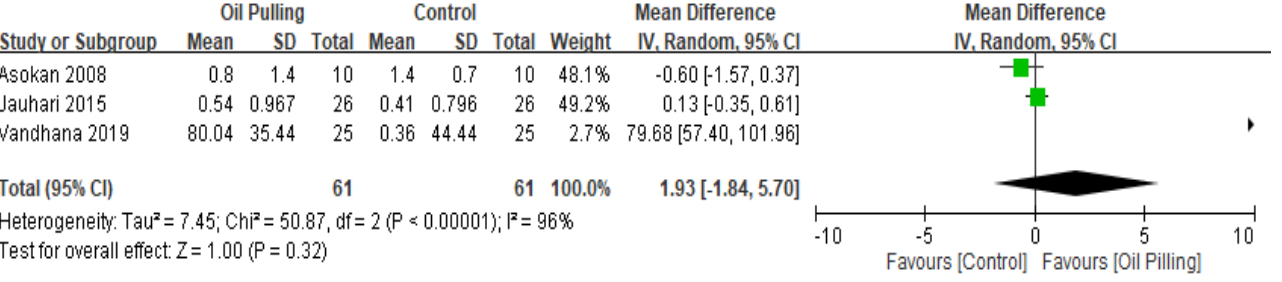
Figure 3. Forest plot for salivary Streptococcus mutans (SM) count.